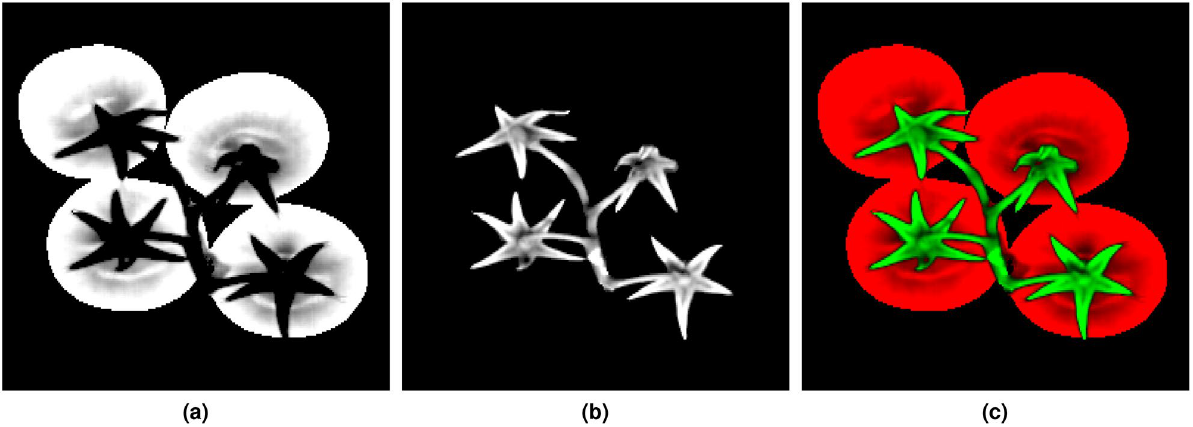
Figure 7. ( a ) Significance masks for tomato ( b ) calyx-stem region and ( c ) pseudo color image created from them.